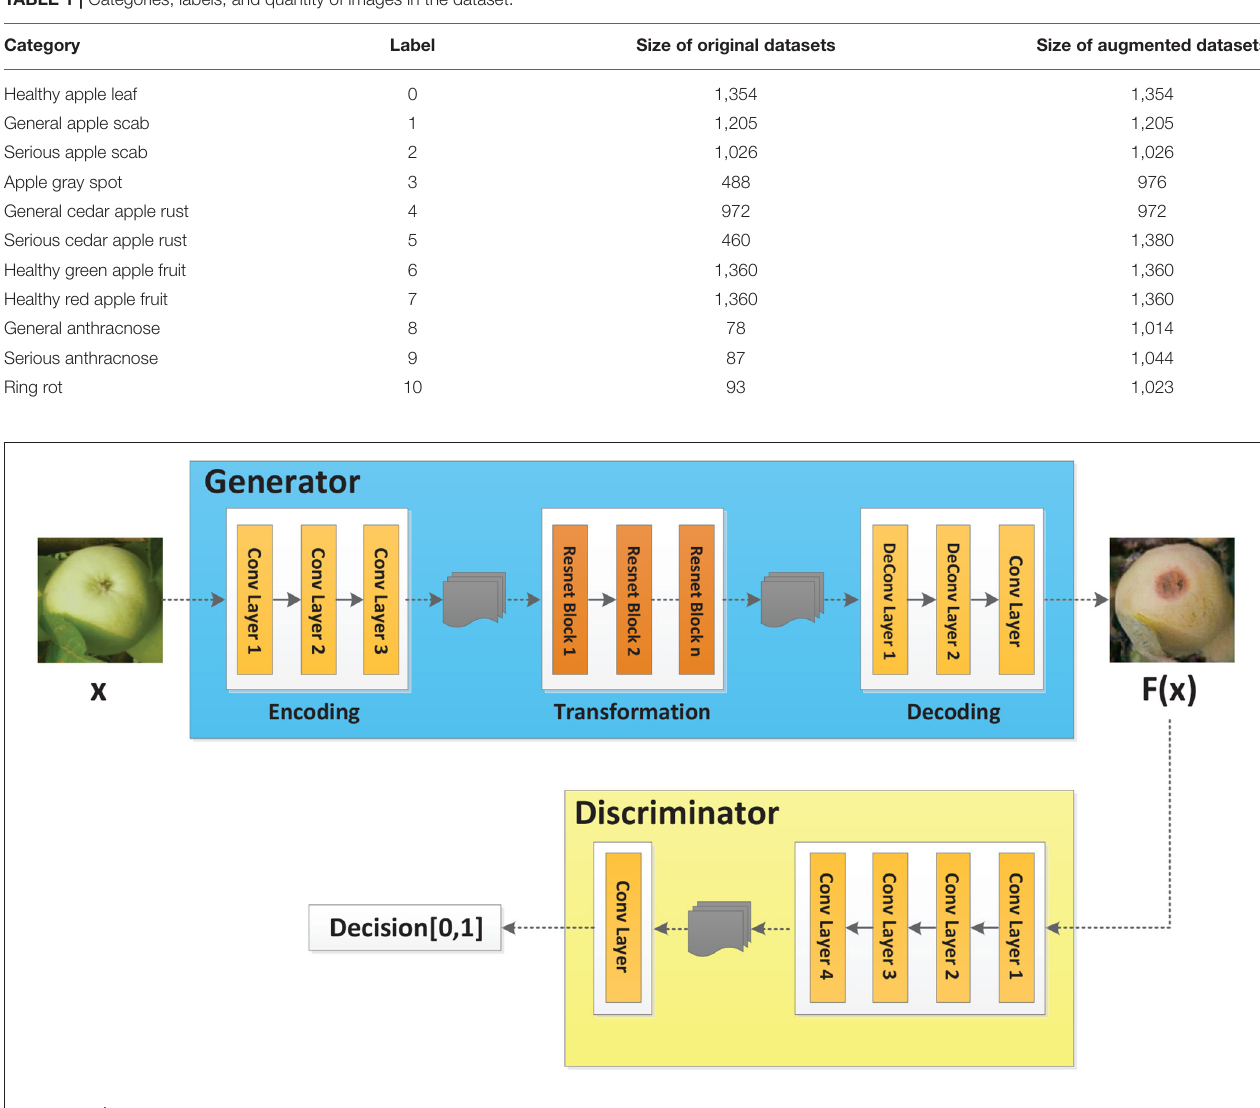
FIGURE 2 | Cycle-GAN